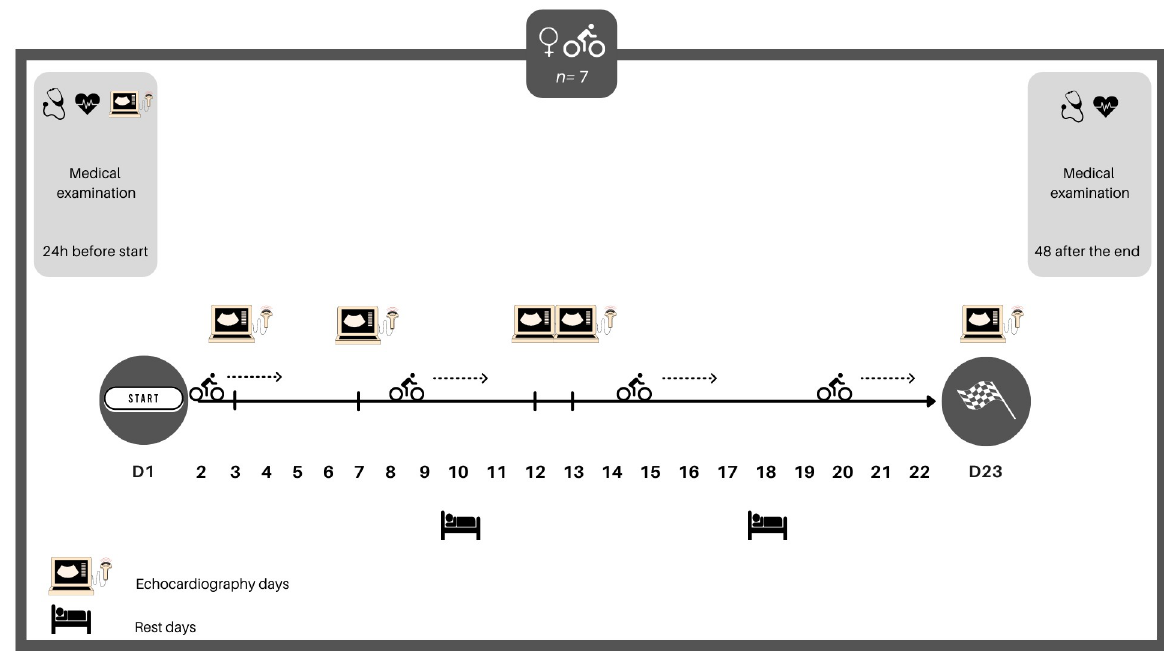
Fig 1. Experimental